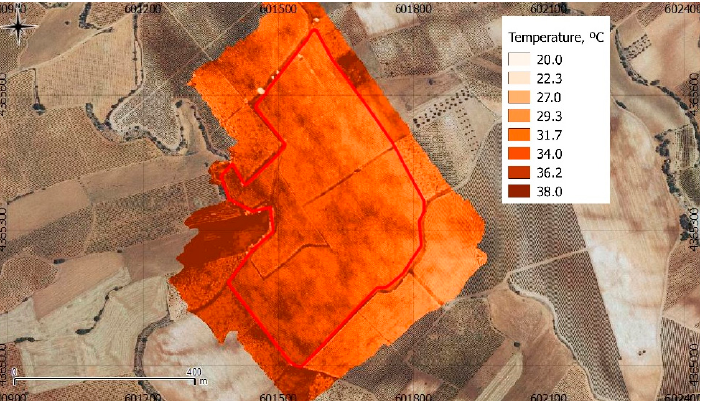
Figure 11. Ortoimage generated using calibrated and filtered images.